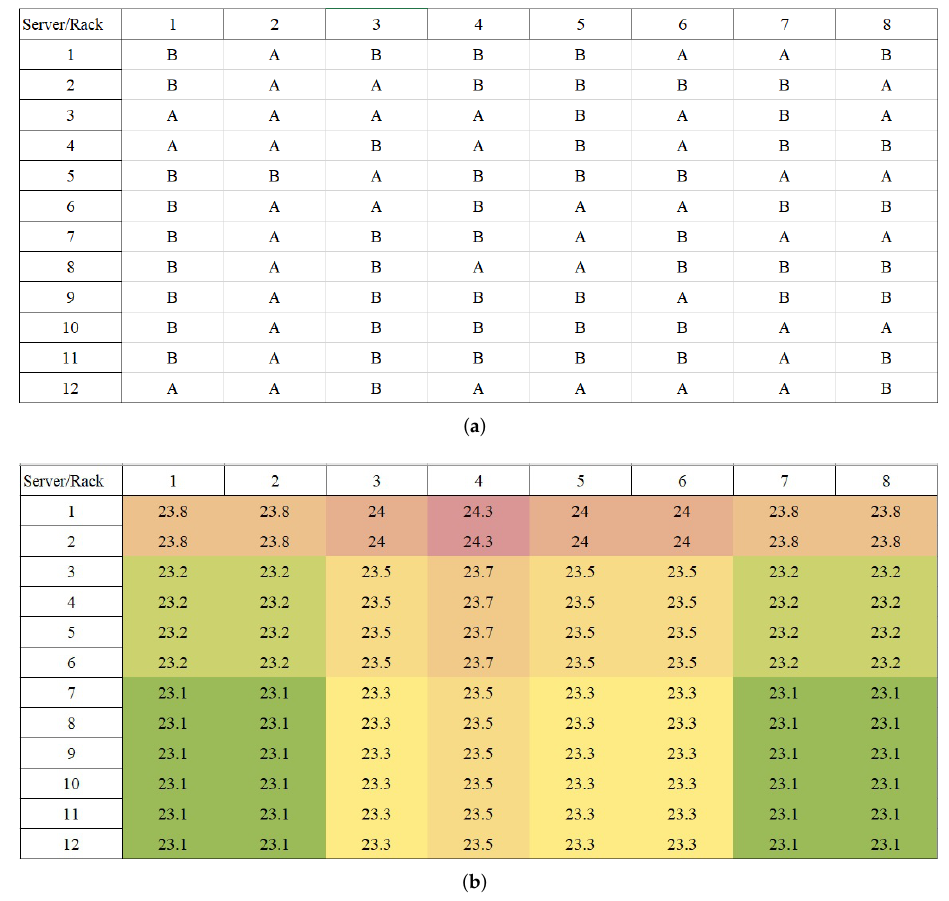
Figure 1. Initial placement of servers in the data center and their inlet temperatures: ( a ) initial placement of SA and SB servers, and ( b ) inlet temperature of data center servers ( ◦